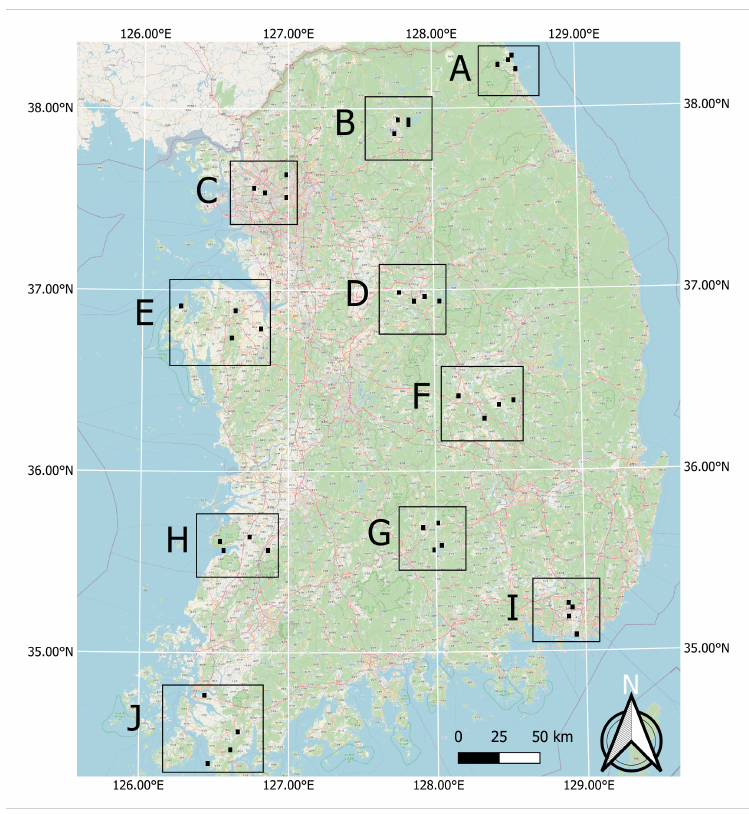
Figure 7. Location of test sites across South Korea. Each site is composed of four plots that are respectively characterized by agricultural, urban, forest and water